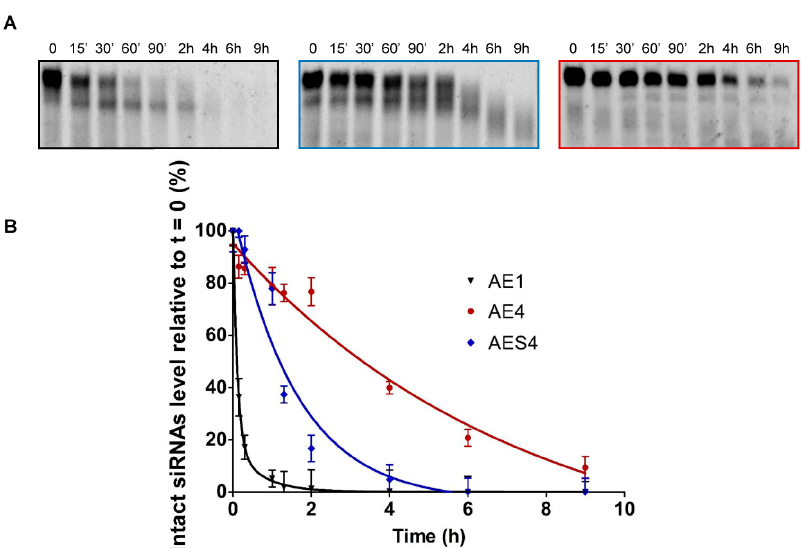
Figure 4. Human serum stability of unmodified and modified siRNAs ( A ) Nucleases stability of native ( AE1 ) (left panel), double PS modified ( AES4 ) (central panel) and double modified ( AE4 ) (right panel) siRNAs; ( B ) Representative degradation curves ( AE1 (black line), AE4 (red line), AES4 (blue line)) of human serum assay. Error bars indicate ± SD; n = 3. For statistical data analysis and experimental procedures see the Experimental